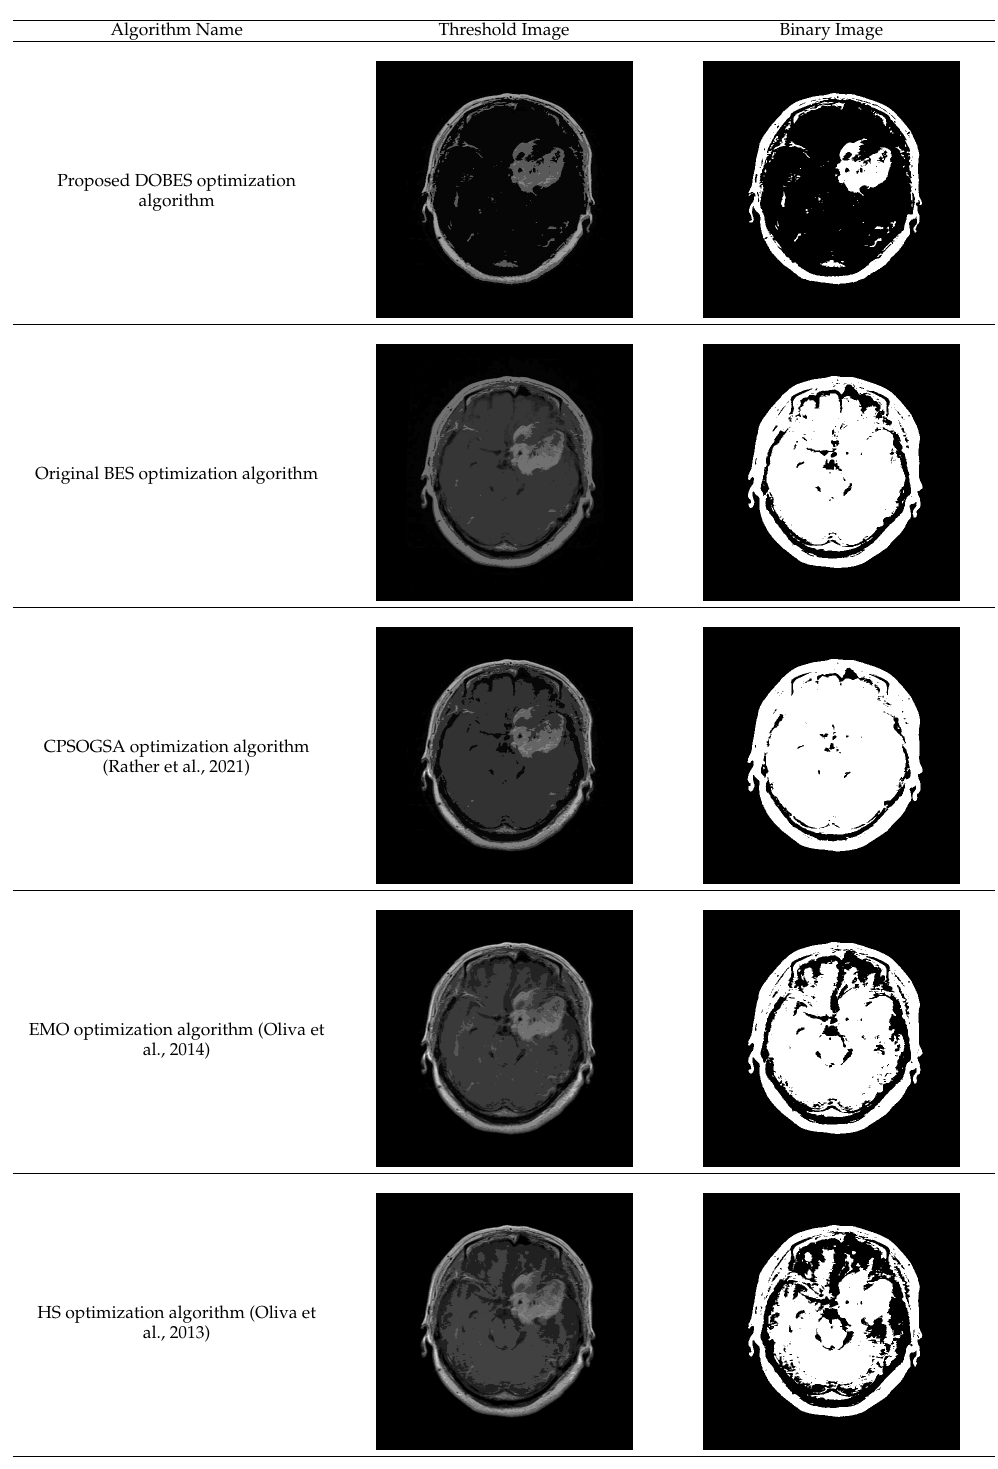
Figure 8. Threshold and binary image of the optimization algorithms obtained using optimization algorithms. DOBES = Dynamic Opposite Bald Eagle Search optimization algorithm, BES = Bald Eagle Search optimization algorithm, CPSOGSA = Constriction Coefficient Based Particle Swarm Optimiza- tion and Gravitational Search Algorithm, EMO = Electromagnetism-like Algorithm, HS = Harmony Search optimization